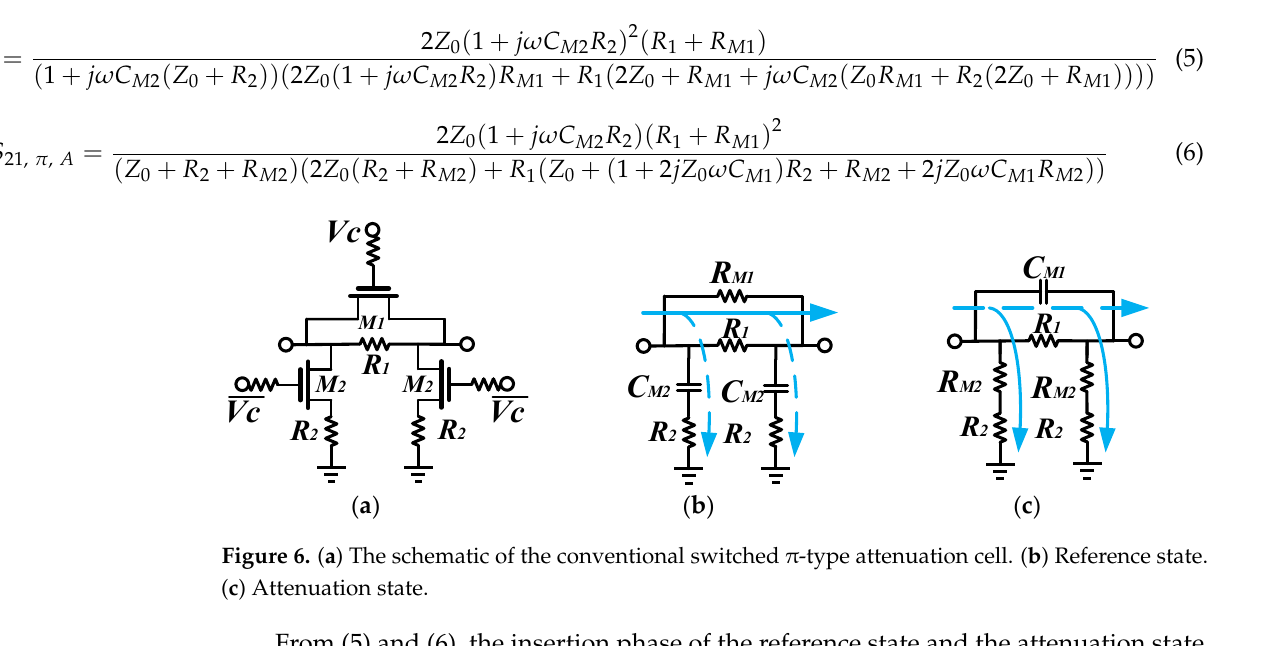
Figure 5. Comparison of the relative attenuation between the conventional and simplified T − type attenuation cell.